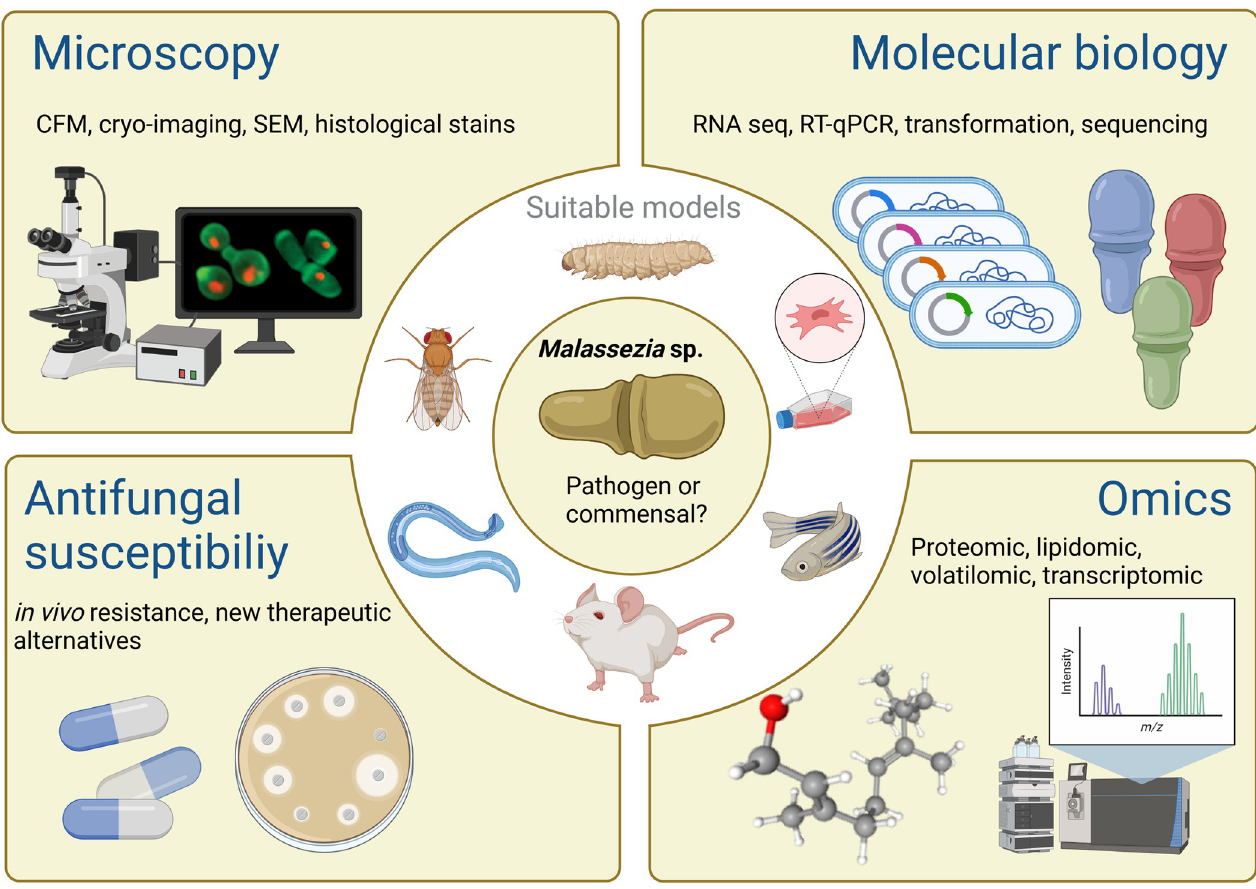
Fig 1. Approaches to study the pathogenicity of Malassezia spp. Various in vivo and in vitro models allow the study of infection processes and the evaluation of the host cellular and molecular responses. Multiple methodologies can be used together in experimental models to better understand Malassezia metabolism and implications in pathogenicity. The image was designed in Biorender.com. FCM, Fluorescence confocal microscopy AU : PleaseprovidefullspellingforCFMinFig 1 abbreviationlistifthisindeedisanabbreviation : ; RT-qPCR, quantitative reverse transcription PCR; SEM, scanning electron microscopy AU : AnabbreviationlisthasbeencompiledforthoseusedinFig 1 : Pleaseverifythatallentriesarecorrect :